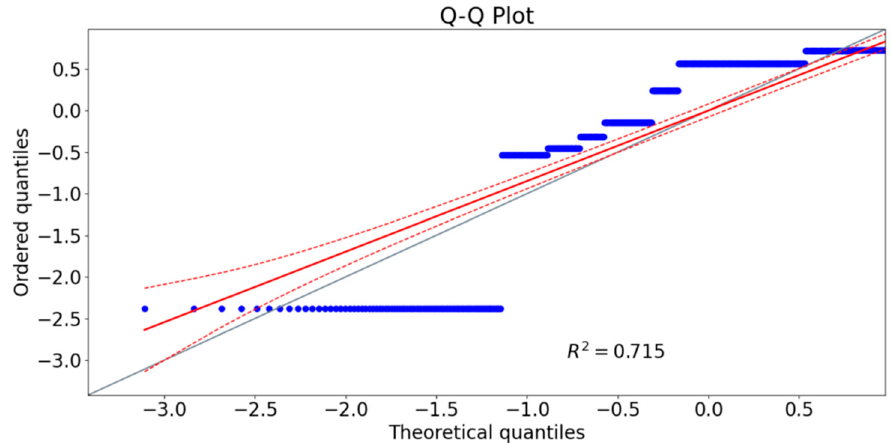
Figure 24. QQ plot of percentage land area and revenue loss (the red dashed line represents 95% confidence interval).